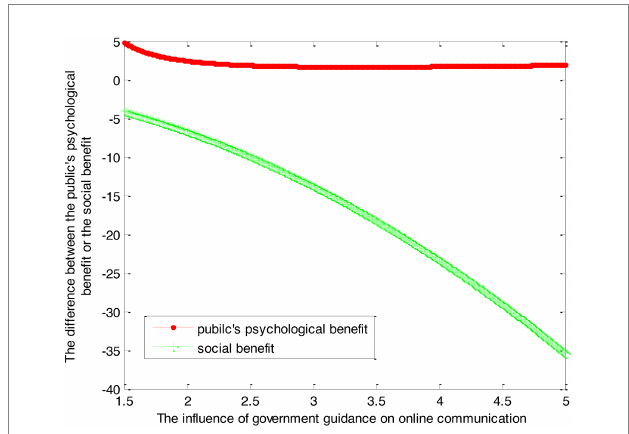
FIGURE 2 The difference between self-guidance and government guidance.